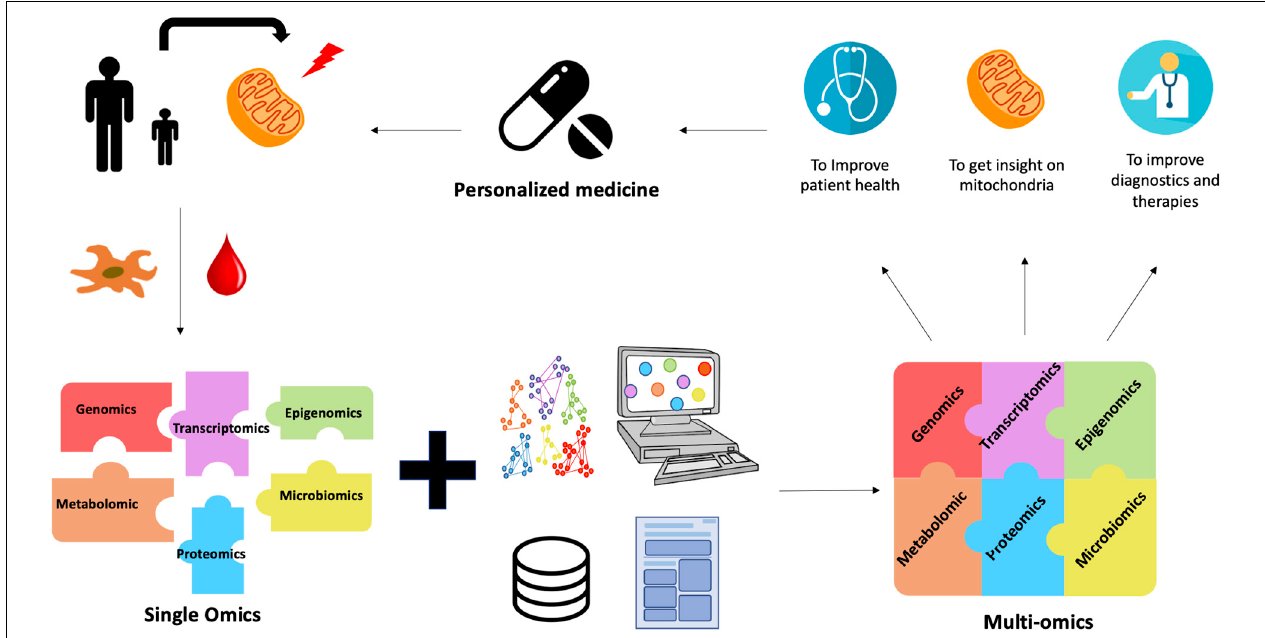
FIGURE 1 | The contribution of multi-omics for MD. Blood or tissue samples (skin or muscle biopsy) are obtained from patients affected by MD. Fibroblasts or myotubes are prepared and cultured from tissue biopsies. Different omics analyses are carried out separately in order to identify the gene(s) responsible for the pathology. However, these analyses are not always conclusive. Despite the validity of the single-omics approach, the complexity of MD limits the success of the diagnosis. This is where multi-omics comes in. Thanks to bioinformatics and the development of algorithms, the integration of data from several different omics analyses is possible and leads to better results. Multi-omics combined with databases and literature provide with a better understanding of mitochondrial diseases. Their diagnosis is therefore improved and a personalized treatment can be proposed for each patient.